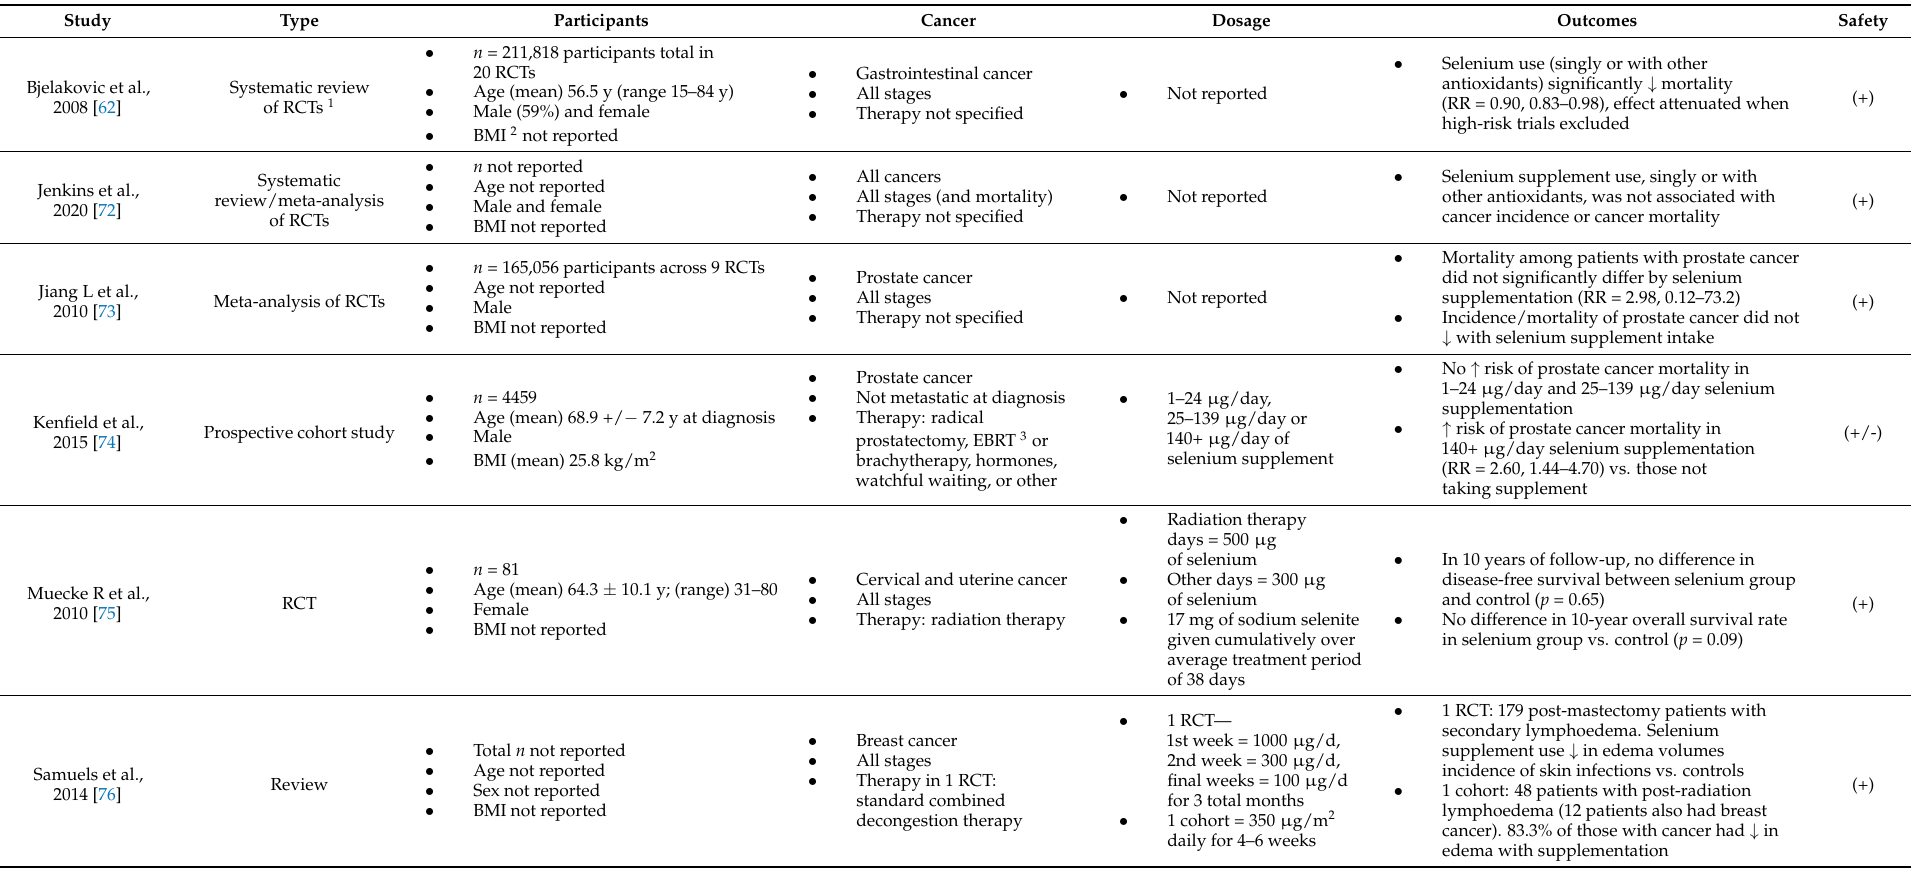
Table 3. Safety of selenium supplements for patients with